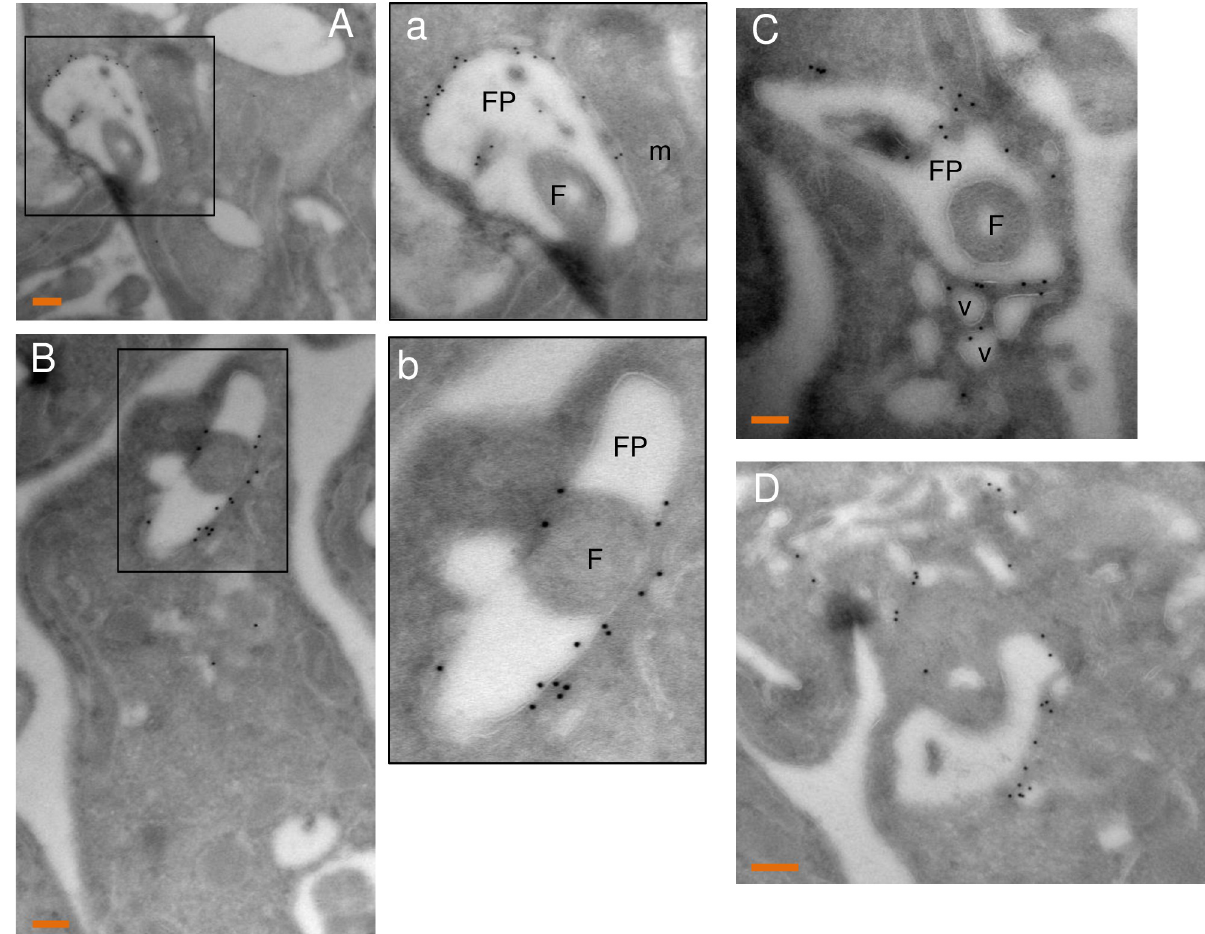
Fig 9. Localization of FHK-HA to the flagellar pocket of procyclic forms by immunoelectron microscopy. Procyclic form parasites expressing FHK C-terminally tagged with HA epitopes were stained with anti-HA revealed by protein-A gold 10 nm particles. A) The gold staining is on the flagellar pocket (FP) membrane but absent from the flagellum (F) and mitochondrion (m). Enlargement of the marked region is shown in panel a. B) Staining is predominantly at the flagellar pocket. Enlargement of the marked region is shown in panel b. C) The staining is sometimes seen on vesicles close to the FP. D) Occasional parasites showed staining outside the flagellar pocket. Bars, 100